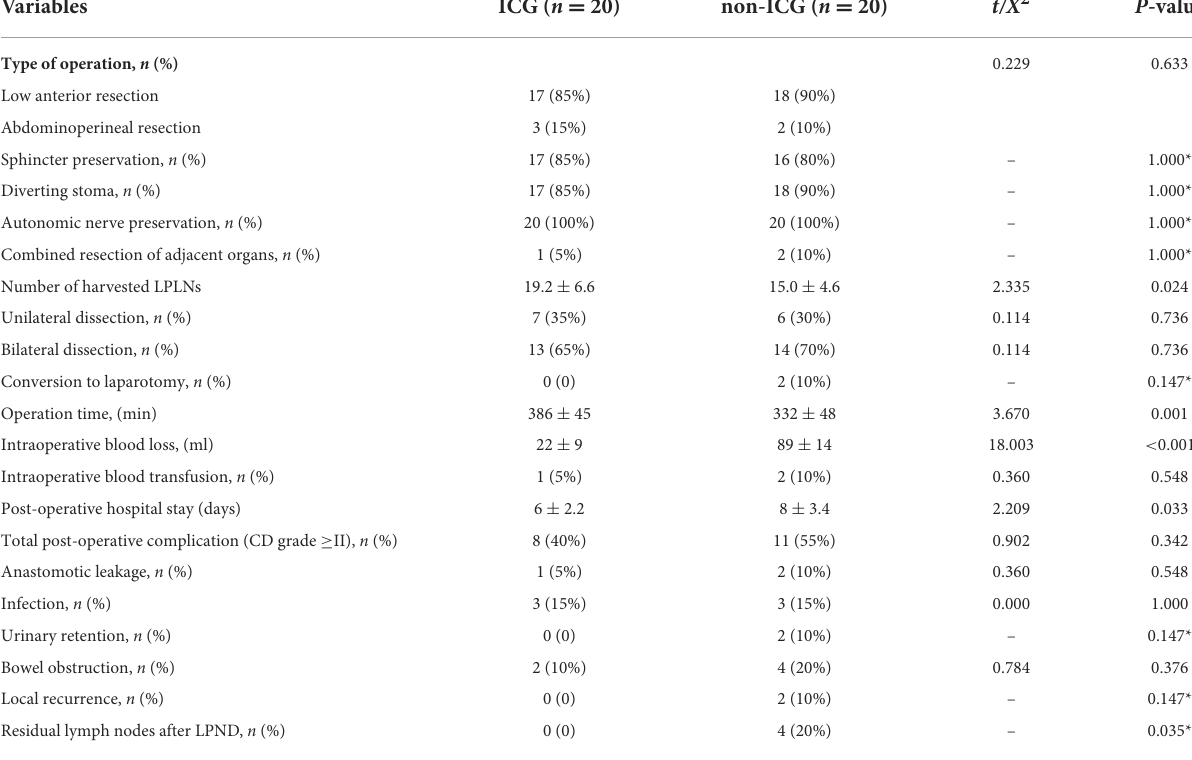
TABLE 3 Comparison of operation